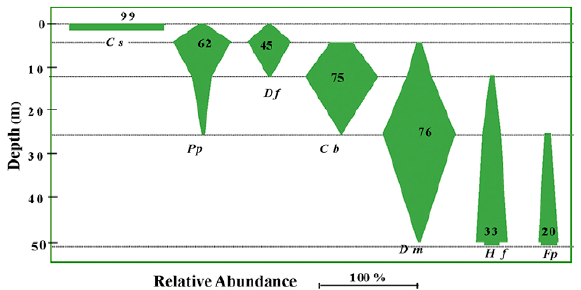
Fig. 2. – Bathymetric distribution of the main erect algal species dominating the assemblages at Estell des Coll (Cabrera, Balearic Islands). Abundance values correspond to the annual average estimated from 16 reticulated quadrats (4 quadrats per depth and season). Numbers represent the abundance percentage at the depth of highest occurrence.